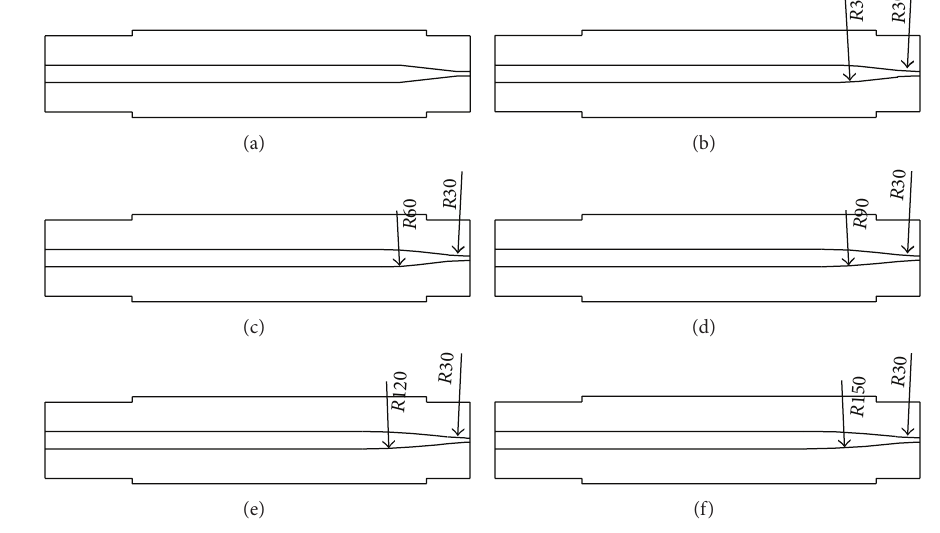
Figure 8: Preliminary structure optimization of CC nozzle.